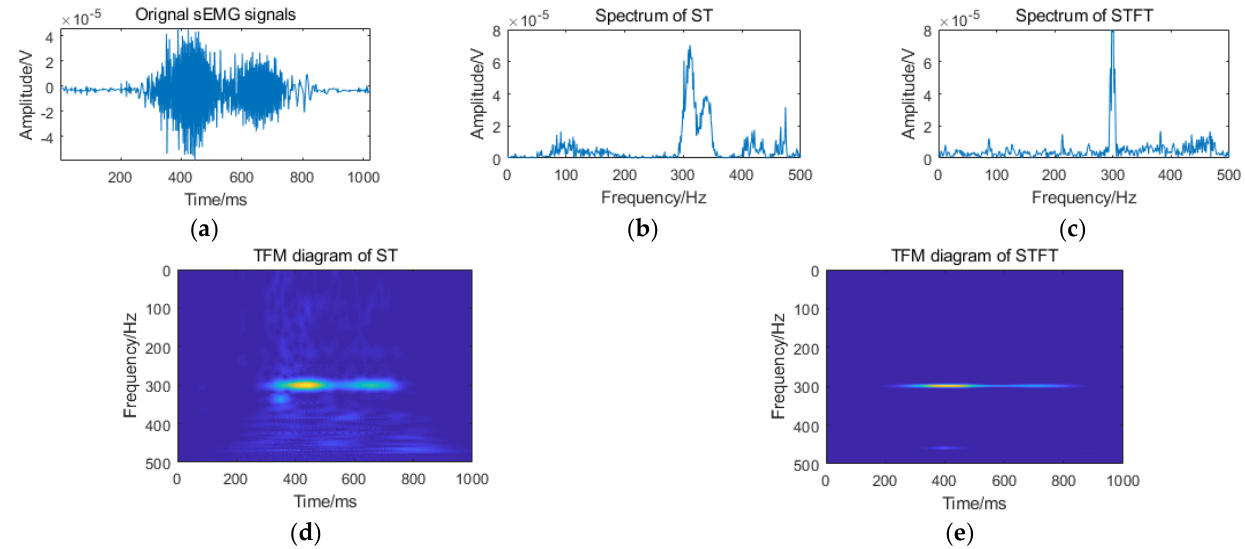
Figure 4. Comparison of the time-frequency diagram of the sEMG signal: ( a ) input sEMG signal; ( b ) spectrum of S-transform (ST); ( c ) spectrum of the short-time Fourier transform (STFT); ( d ) time-frequency matrix (TFM) diagram of ST; and ( e ) TFM diagram of STFT.